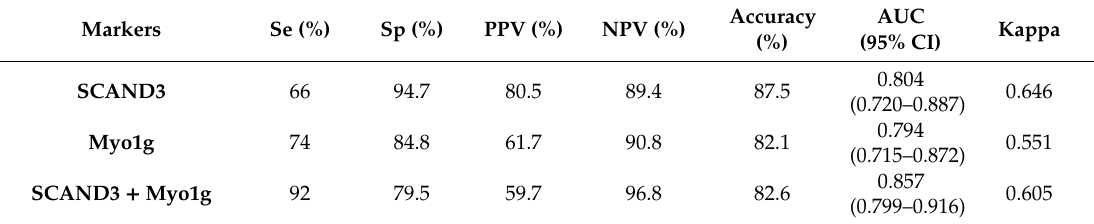
Table 3. Diagnostic values of SCAND3 and Myo1g methylation levels in AFP-negative HCC